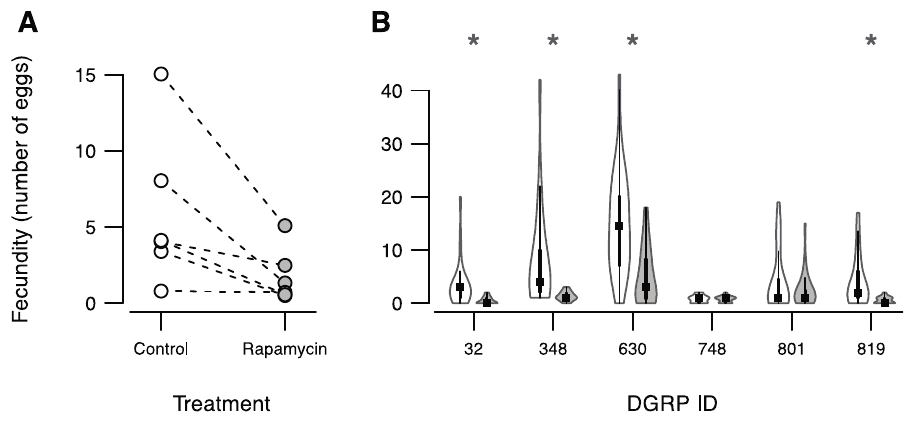
Figure 2. Effects of rapamycin treatment on D. melanogaster fecundity. ( A ) Interaction plot of DGRP genotypes across the two treatments. Points represent within line and treatment means. ( B ) Violin plots showing the distribution of fecundity as number of eggs. Each violin represents the distribution of data with a boxplot inside where the median is indicated by a black square. Significant difference in fecundity within lines are indicated with asterisks ( p -value < 0.05). The median lifespan of the control-treated male flies was between 28.5 days and 53.0